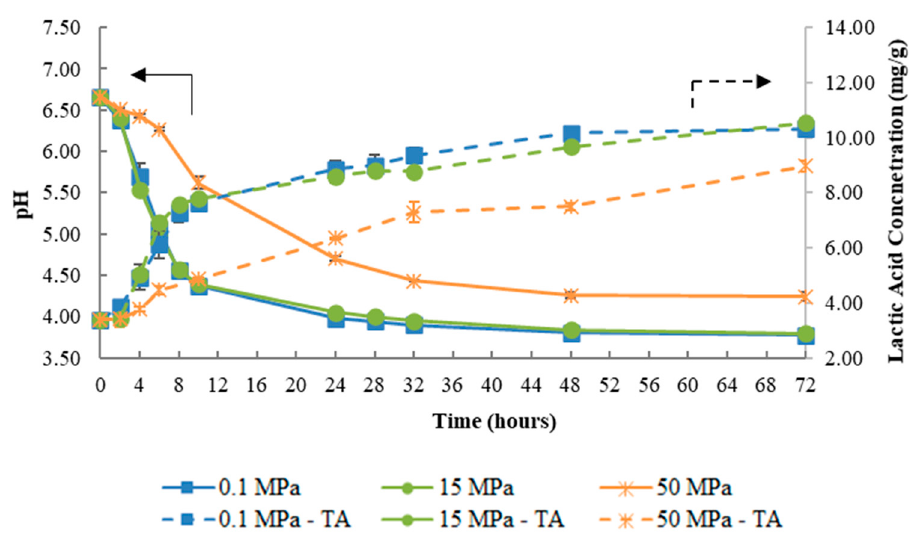
Figure 2. Variation of pH (solid lines) and titratable acidity (TA (broken lines), expressed as lactic acid concentration, mg / g) during fermentation under 0.1, 15, and 50 MPa at 25 ◦ concentration, mg/g) during fermentation under 0.1, 15, and 50 MPa at 25 °C.